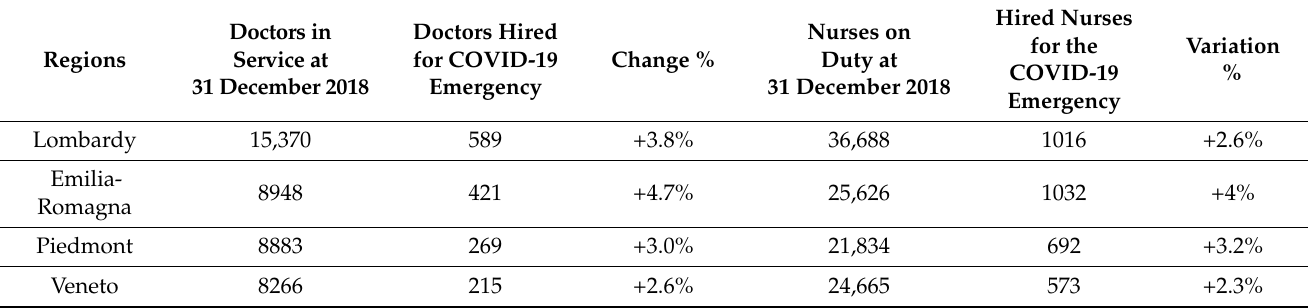
Table 3. Percentage changes in employee integration in May